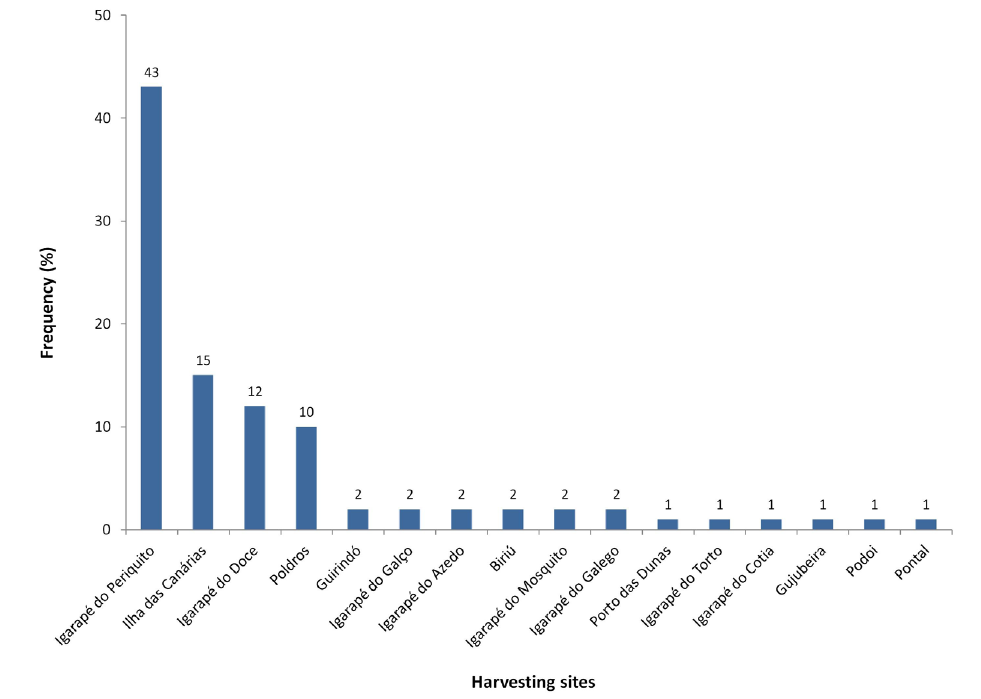
Figure 4. Frequency (%) of citation of Ucides cordatus sites in the Parnaíba River Delta, Brazil. N =